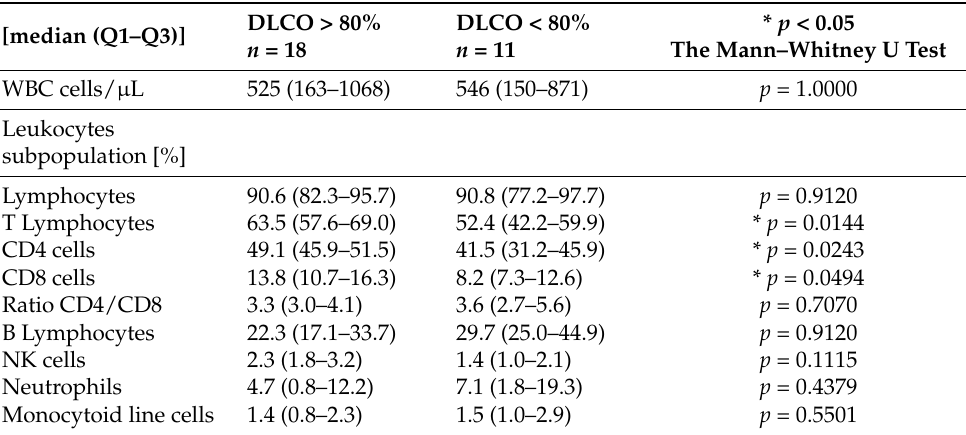
Table 2. The differences in the median of white blood cells (WBC) count and median proportion of leukocytes subpopulation in lymph nodes (LNs) between sarcoidosis patients with normal diffusion: DLCO > 80% and with reduced diffusion: DLCO < 80%. Data expressed as median (Q1–Q3). A * marked p < 0.05 statistically significant.